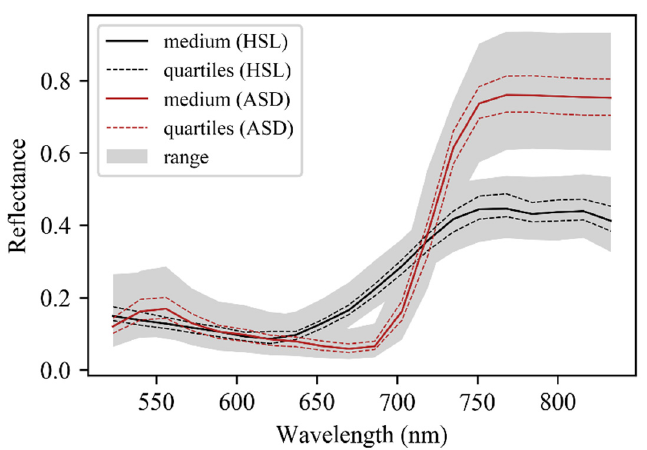
Figure 5. Overview of leaf reflectance spectrum of 74 leaf samples measured by HSL and ASD system. The continuous black line stands for the median reflectance spectrum, the dashed red line stands for the first or third quartile reflectance spectrum, and the grey shaded area stands for the range of all reflectance spectrum.